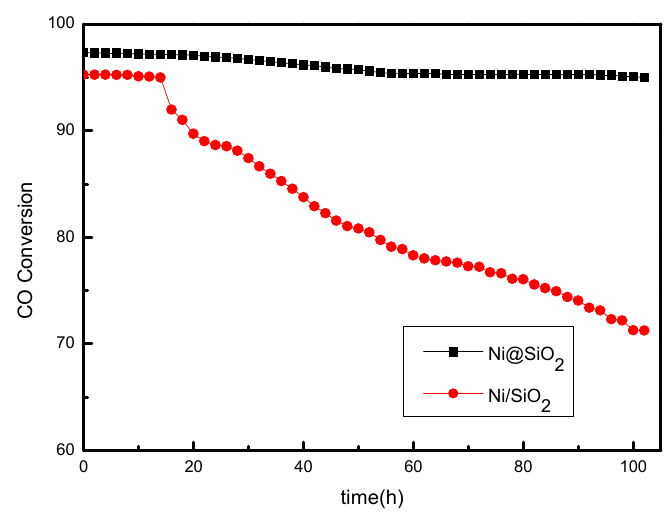
Figure 6. Stability of the Ni@SiO 2 catalyst for CO methanation at 500 °C, 1.5 MPa, 36,000 mL/g/h.